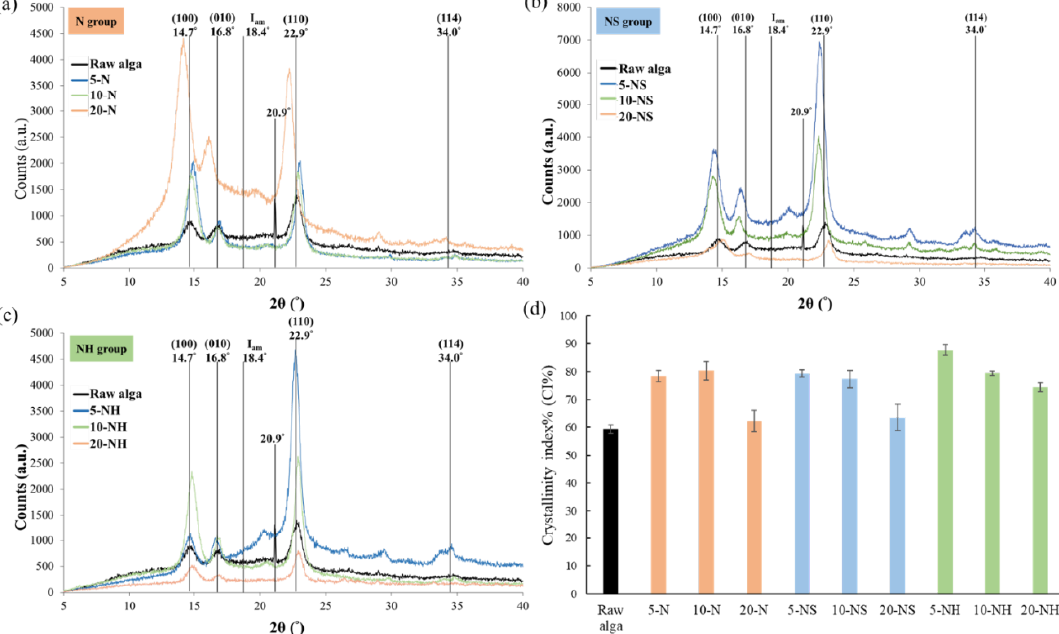
Figure 3. XRD spectra of the ( a ) N group, ( b ) NS group, and ( c ) NH group Rhizoclonium pulp samples, and ( d ) the CI% of the Rhizoclonium pulp.